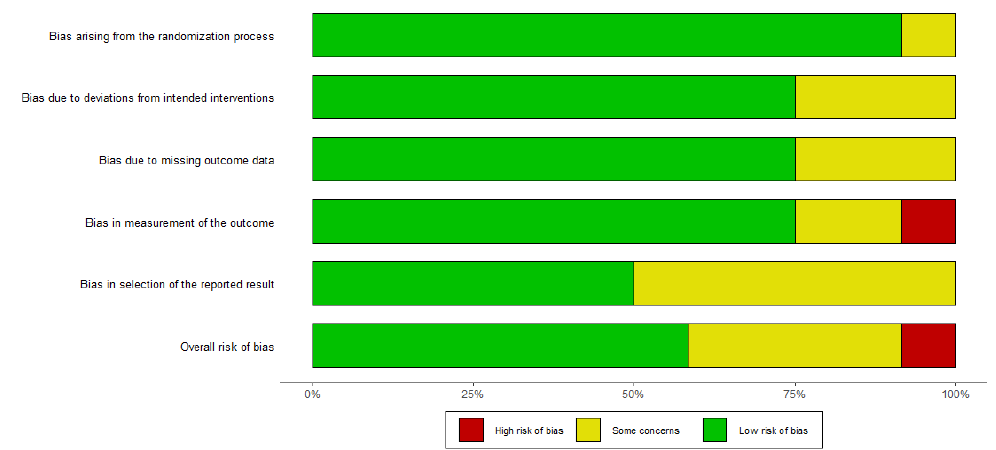
Figure 3. Risks of bias graph expressed as percentages.